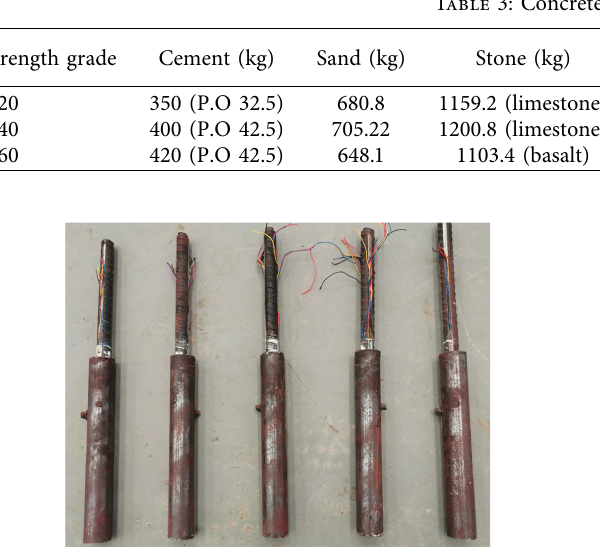
Figure 2: Steel tube country rock specimens.